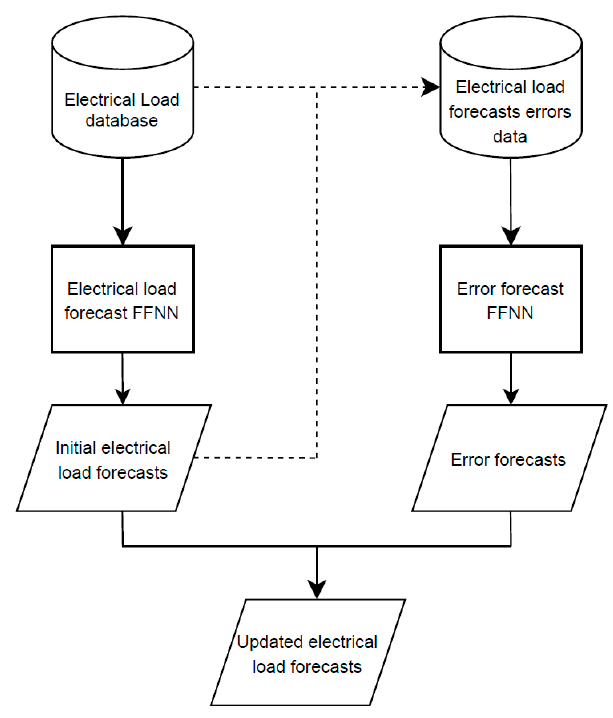
Figure 2. Electrical load forecast methodology.